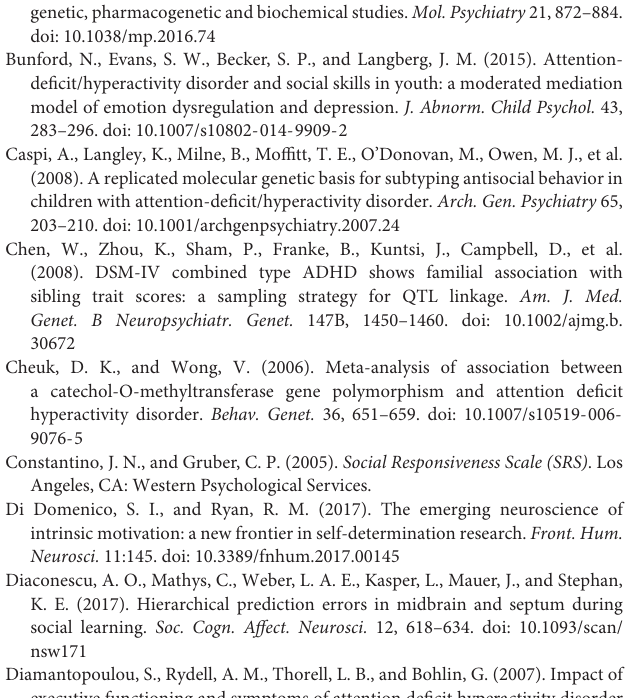
FIGURE S1 | Differences between French data and data from the other IMAGEN centers were also found in the subscales social cognition, social communication, social motivation, and social awareness. Excluded French data: N =